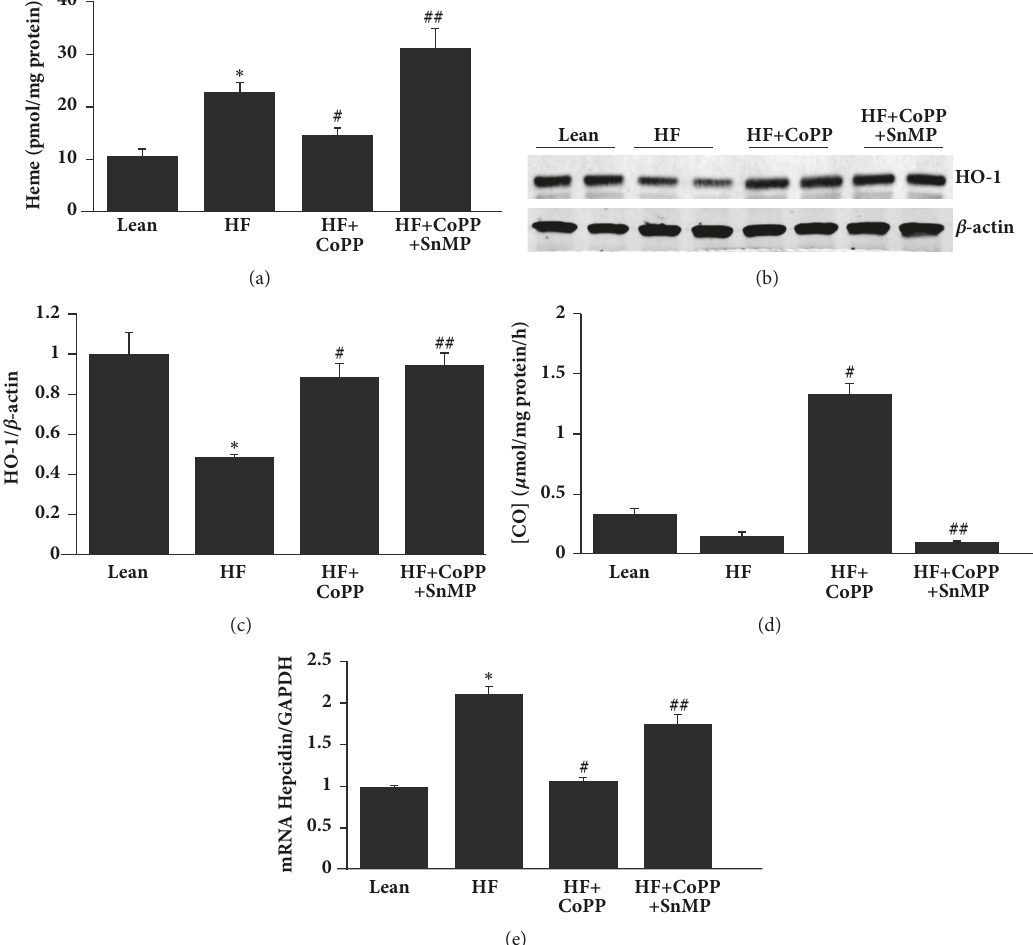
Figure 3: Increase of HO-1 decreases heme levels and hepcidin expression. (a) Heme (pmol/mg protein) content, (b) representative western blots of HO-1, (c) densitometry analysis of HO-1 and (d) CO production ( 𝜇 mol/mg protein/h), and (e) mRNA expression of hepcidin in hepatic tissues of control lean mice, HF fed mice, HF fed mice + CoPP, and HF fed mice + CoPP + SnMP. Results are mean ± SE, n=6, ∗ p < 0.05 versus lean mice, #p < 0.05 versus HF fed mice, and ##p < 0.05 versus HF fed mice treated with